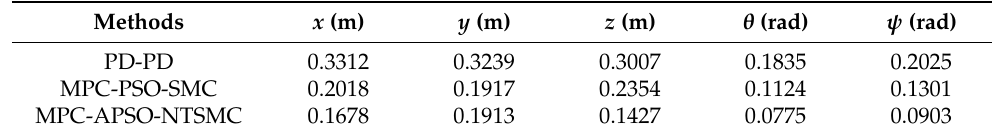
Figure 16. Velocity tracking of the AUV with random disturbance for Case 1. Table 4. Position MAE with random disturbance after 20 s for Case